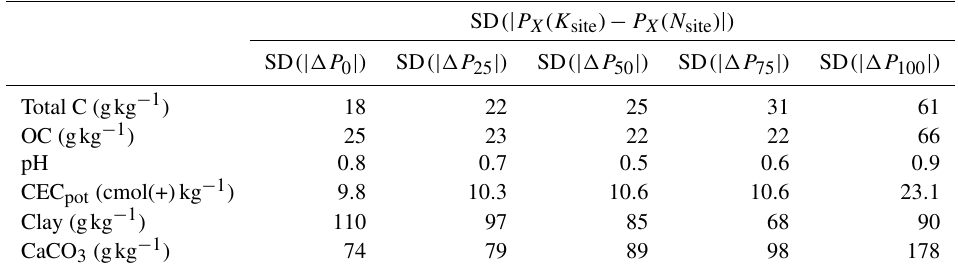
rate estimates of total C were achieved (RMSE = 8 . 4 gkg − 1 ; RPIQ =